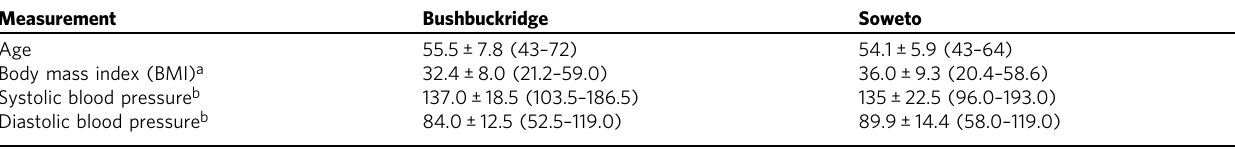
Table 1 Participant